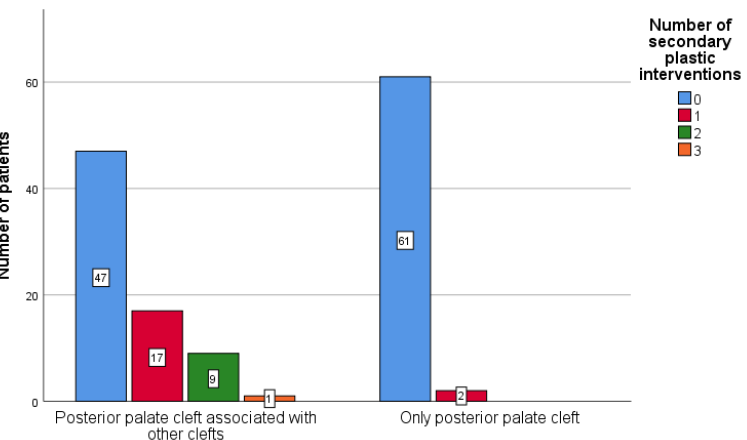
Figure 7. Frequency of secondary palatal surgical interventions based on the type of cleft.